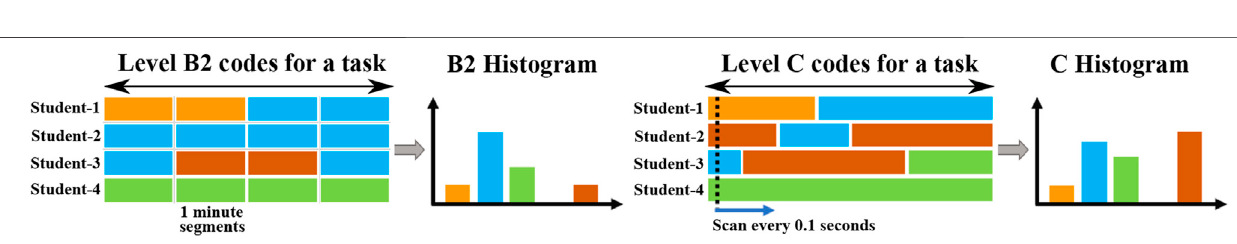
Frontiers in Computer Science |